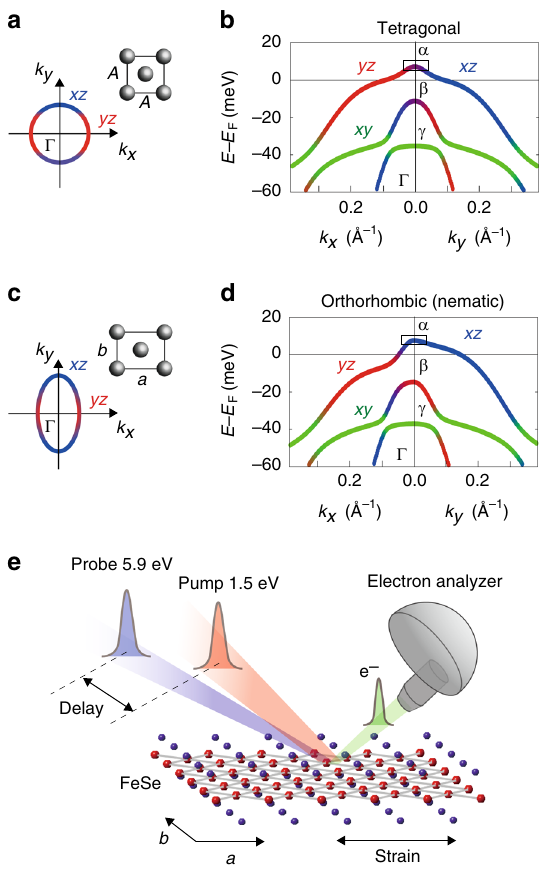
Fig. 1 Electronic structure of FeSe and experimental setup for TARPES. a Schematic Fe lattice and Fermi surface around the Γ point in the tetragonal phase. x and y are coordinates along the crystal axes of the orthorhombic setting a and b ( a > b ), respectively. b Band dispersions and orbital characters in the tetragonal phase obtained by a band calculation including the spin – orbit coupling 17 . α , β , and γ denote the outer, middle, and inner hole band, respectively. c , d , The same as a and b but for the orthorhombic phase. For reproducing the ARPES results (Supplementary Note 1), the spin – orbit coupling and orbital polarization were included in the band calculations in d (ref. 17 ). e Schematic experimental geometry of TARPES on detwinned bulk